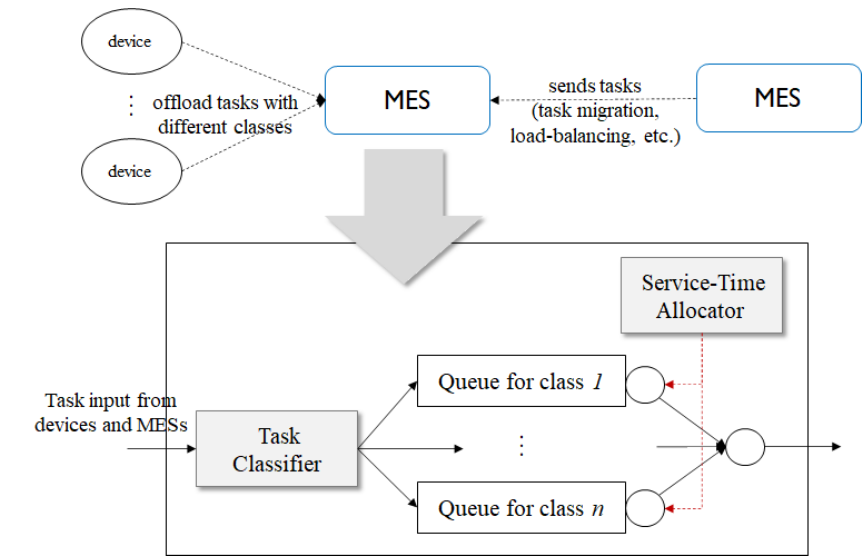
Figure 1. System